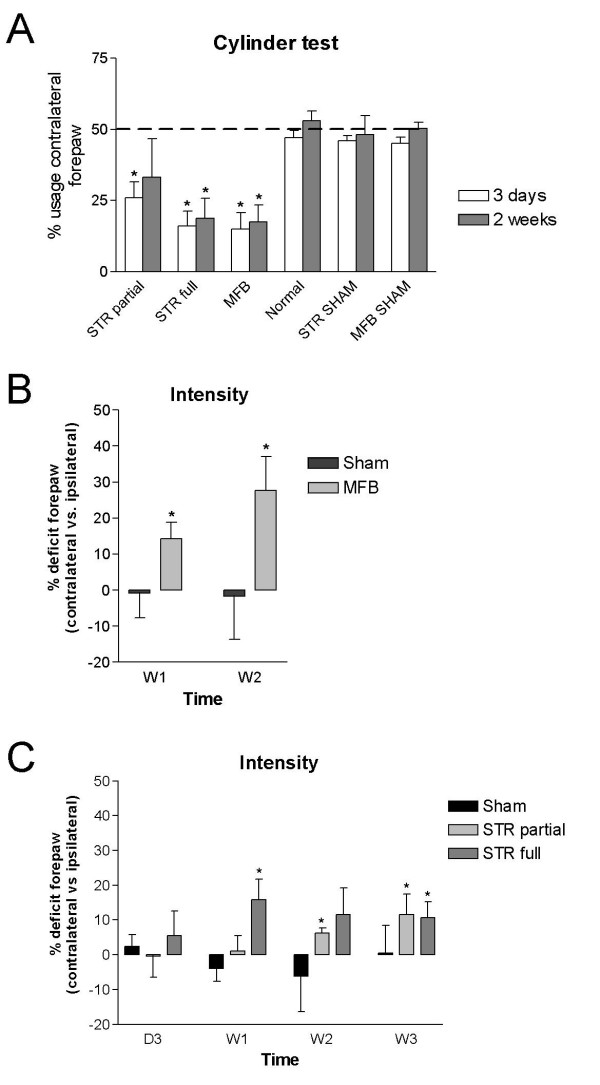
Motor deficits following unilateral lesioning in rat basal ganglia using 6-OHDA. (A) Proportion of limb use of 'lesioned' paws in 6-OHDA experimental groups as well as in normal rats and sham controls as measured in the limb-use asymmetry ('cylinder') test. Dashed line at 50% indicates the average expected paw usage in normal rats. (B) Deficits in pawprint intensity recorded via the catwalk method (expressed as % difference of contralateral vs. ipsilateral forepaws) in 6-OHDA medial forebrain bundle lesion or sham rats at 1 and 2 weeks post-lesion. (C) Deficits in pawprint intensity recorded via the catwalk method (expressed as % difference of contralateral vs. ipsilateral forepaws) in 6-OHDA striatal lesion or sham rats at 3 days, 1, 2 and 3 weeks post-lesion. Data are shown as mean ± s.e.m. * p < 0.05.